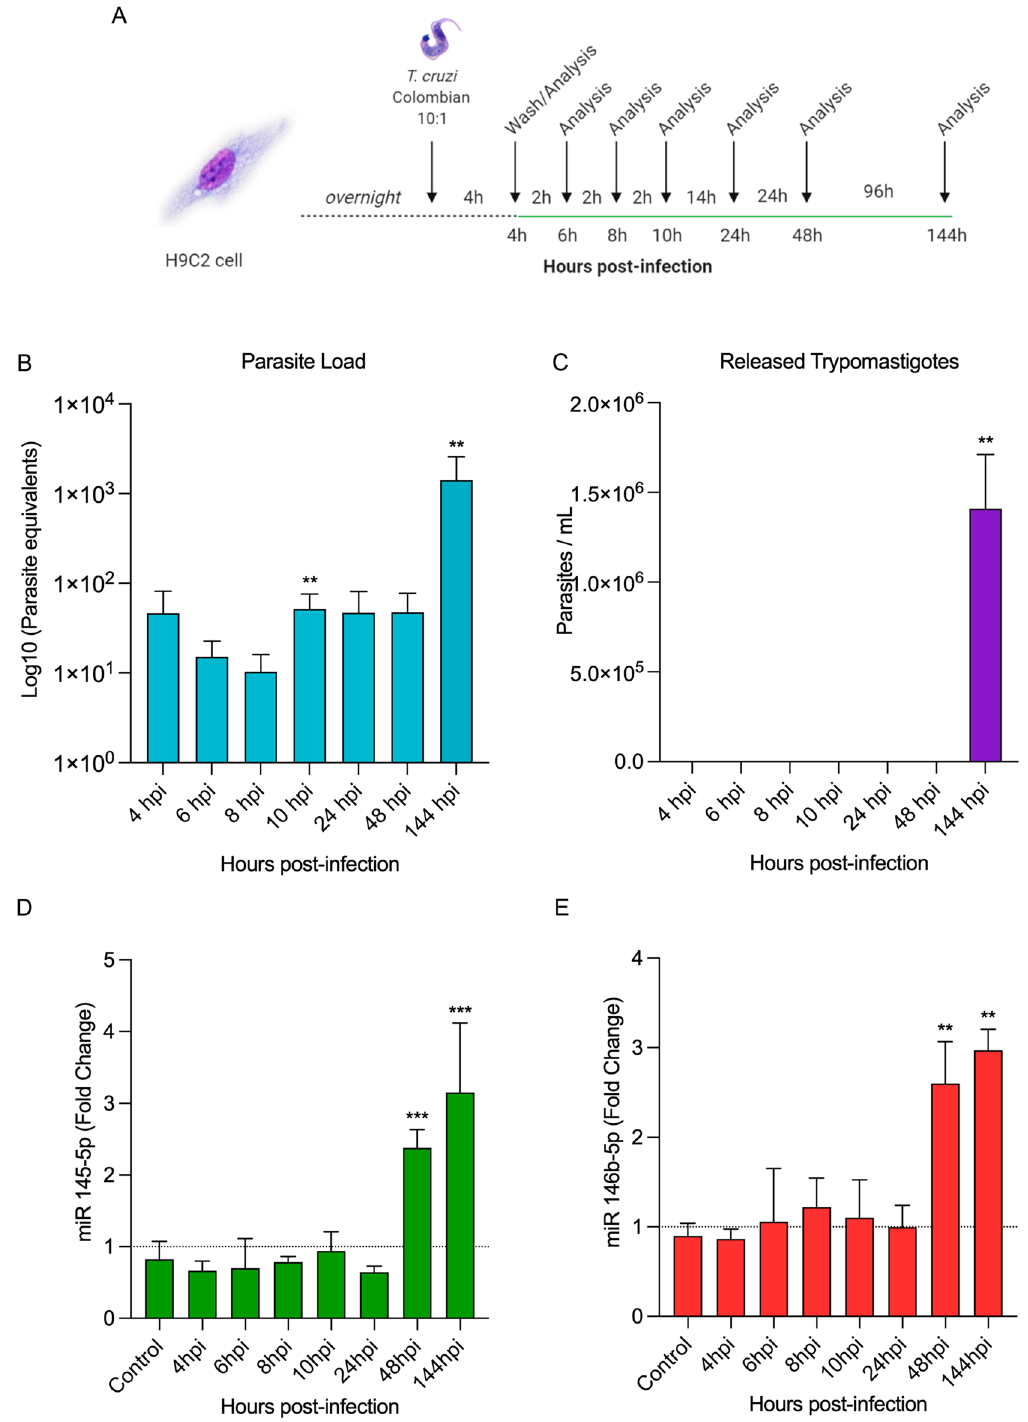
Figure 2. T. cruzi infection modulates miR-145-5p and miR-146b-5p expression. ( A ) H9C2 cells were infected with 10:1 T. cruzi trypomastigotes for 4 h, washed and collected 4, 6, 8, 10, 24, 48 and 144 h post-infection. ( B ) Parasite load of H9C2 cells infected with T. cruzi . ( C ) Concentration of parasites released into the supernatant. ( D ) miR-145-5p levels, ( E ) miR-146b-5p levels. For all graphs, significance was determined using unpaired Student’s t test (*p < 0.05, **p < 0.01, ***p < 0.001). The experiment was repeated three times, using different cell culture flasks in each experimental